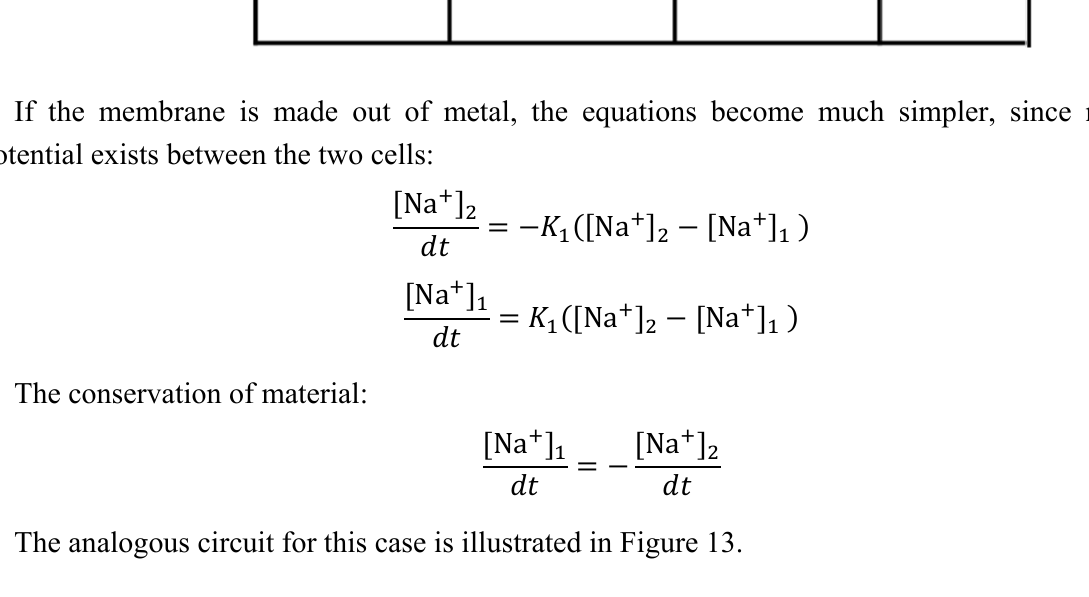
Figure 13. The analogous electrical circuit of concentrations [Na + ] related to a flow through a metallic